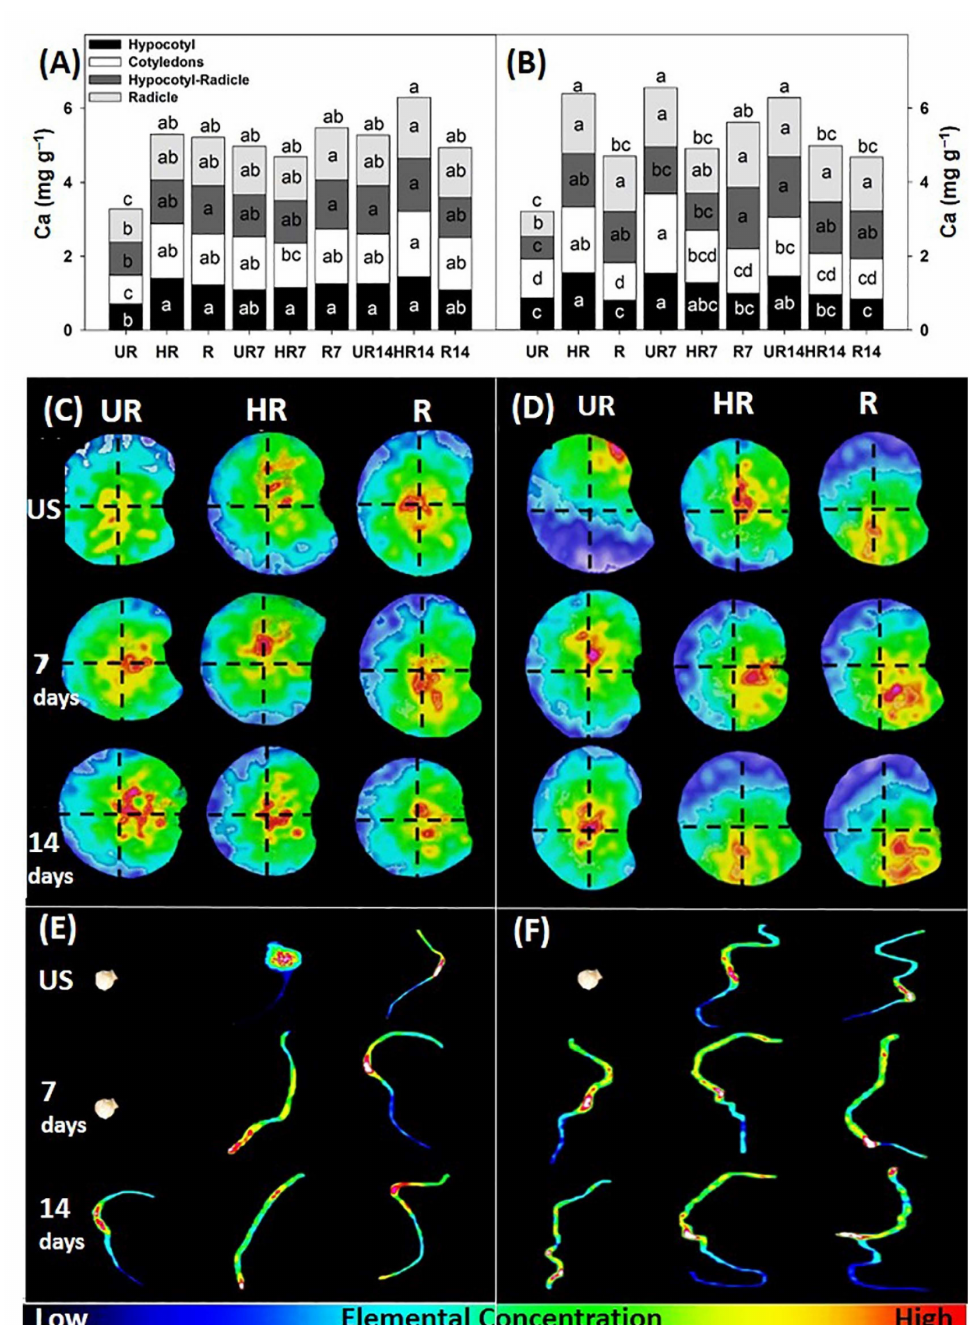
Figure 3. Ca concentration in seeds pre-imbibition ( A ) and post-imbibition ( B ), Ca distribution in habanero pepper seeds pre-imbibition ( C ) and post-imbibition ( D ), habanero seedlings at 10 ( E ) and 14 days ( F ) after sowing, of seeds of unripe (UR), half-ripe (HR), and ripe (R) fruits; unstored (US) and stored for 7 and 14 days postharvest. Colors in panels ( C – F ) are based on a relative intensity scale (reported at the bottom of the figure) generated on the intensity of the X-ray fluorescence K α peak of Ca in the samples. Data are means. Different letters indicate statistically significant differences among treatments (Duncan, p ≤ 0.05, n =